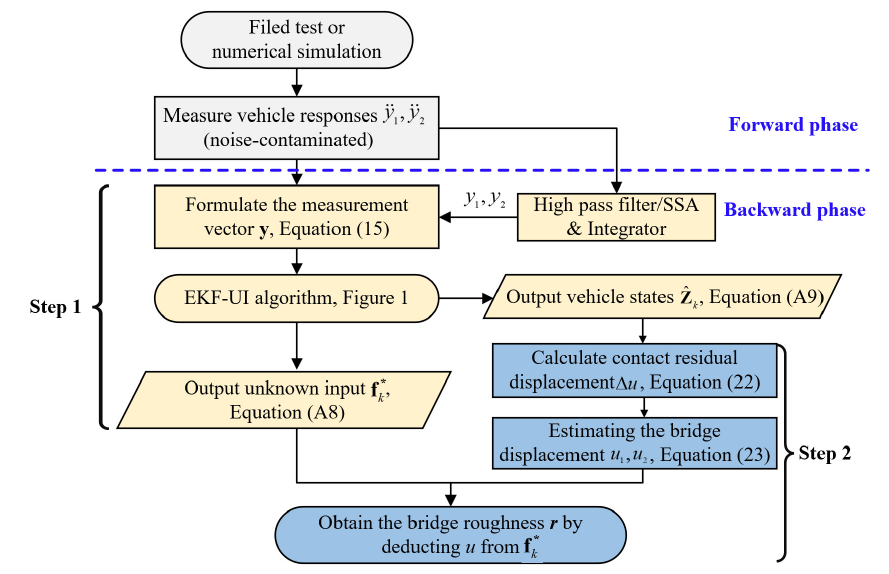
Figure 3. Flowchart of the proposed technique.